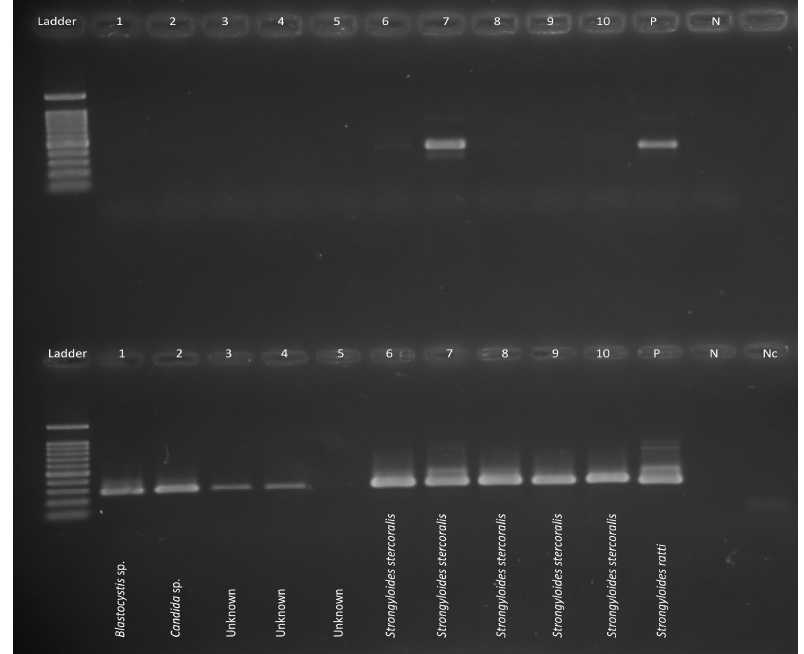
Figure 2. Conventional nested PCR testing a subset of samples, with primary PCR on the top row and secondary PCR on the bottom row. A 100 bp ladder (Promega) is used as a marker in the first lane. Strongyloides ratti was used as the positive control along with negative controls. The primers are non-specific therefore the single strand conformational polymorphism (SSCP) method was employed (see Figure 3).